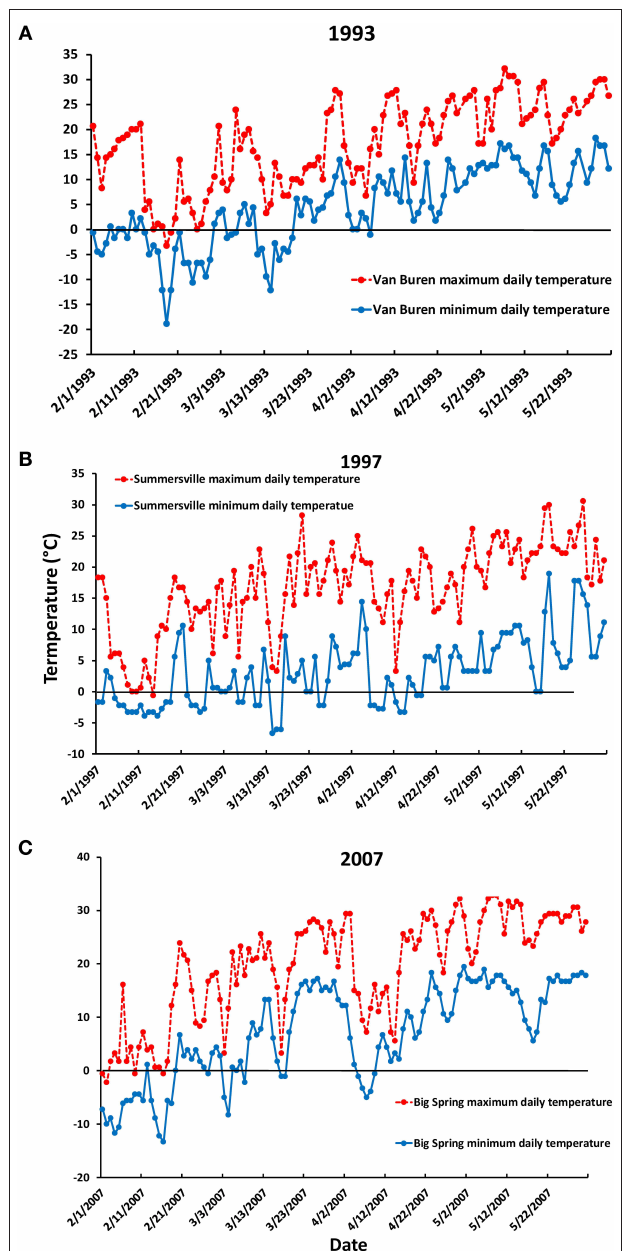
FIGURE 2 | Daily maximum and minimum temperatures for (A) 1993, Van Buren weather station, (B) 1997, Summersville weather station, (C) 2007, Big Spring weather station (https://www.ncei.noaa.gov). See text for station locations.